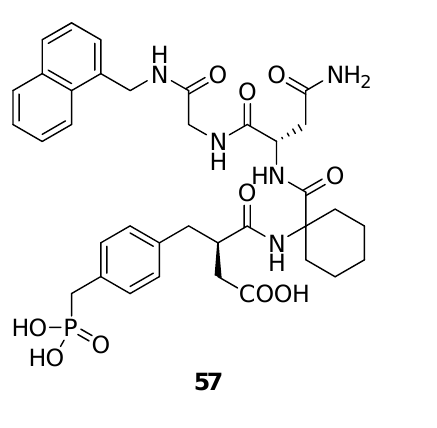
Figure 15. Macrocyclization by RCM converts 57 from a low micromolar to nanomolar Grb2 SH2 domain binding ligands.